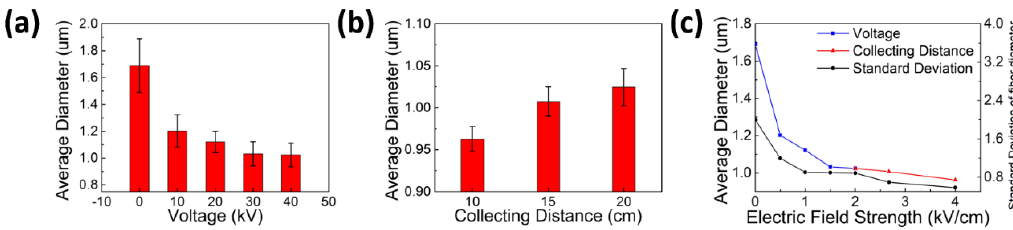
Figure 3. Fiber diameter of fabric prepared under different voltages ( a ), collecting distances ( b ), and electric field strength’s influence on average diameter ( c ). The error bars in ( a , b ) represent the standard deviation of fiber diameter for each group of samples.